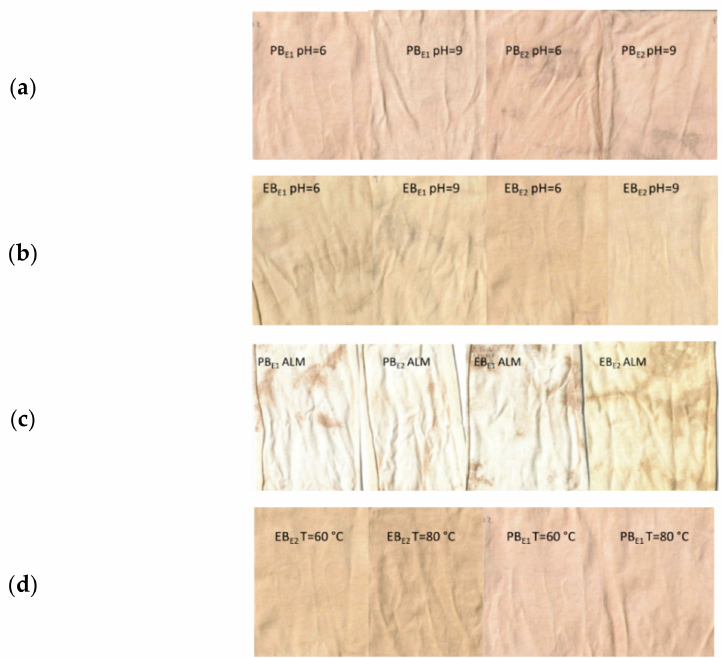
Figure 2. Cotton textile samples: ( a ) Dyed with PB E1 and PB E2, pH influence; ( b ) Dyed with EB E1 and EB E2 pH influence; ( c ) Dyed with to PB E1 , PB E2 , EB E1 and EB E2 Alum as Mordant influence, ( d ) Dyed with EB E2 and PB E1 , dyeing temperature influence, pH unmodified, dyeing conditions: S/L = 1/15, 30 min, 60 ◦ C.